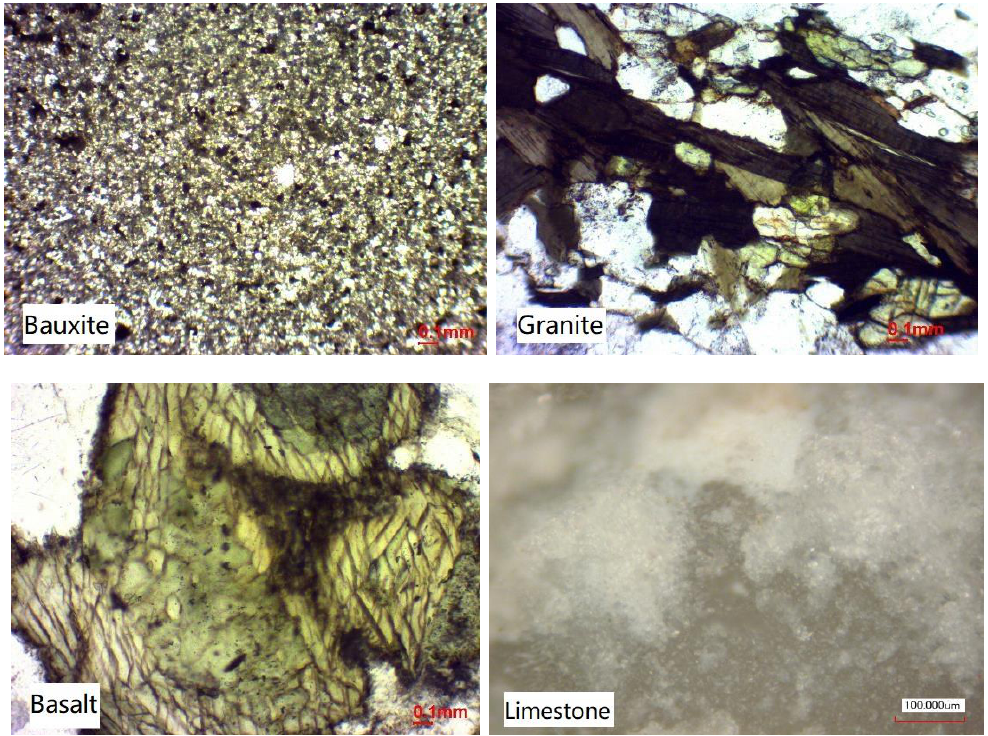
Figure 2. Laser microscope images of the four aggregates.